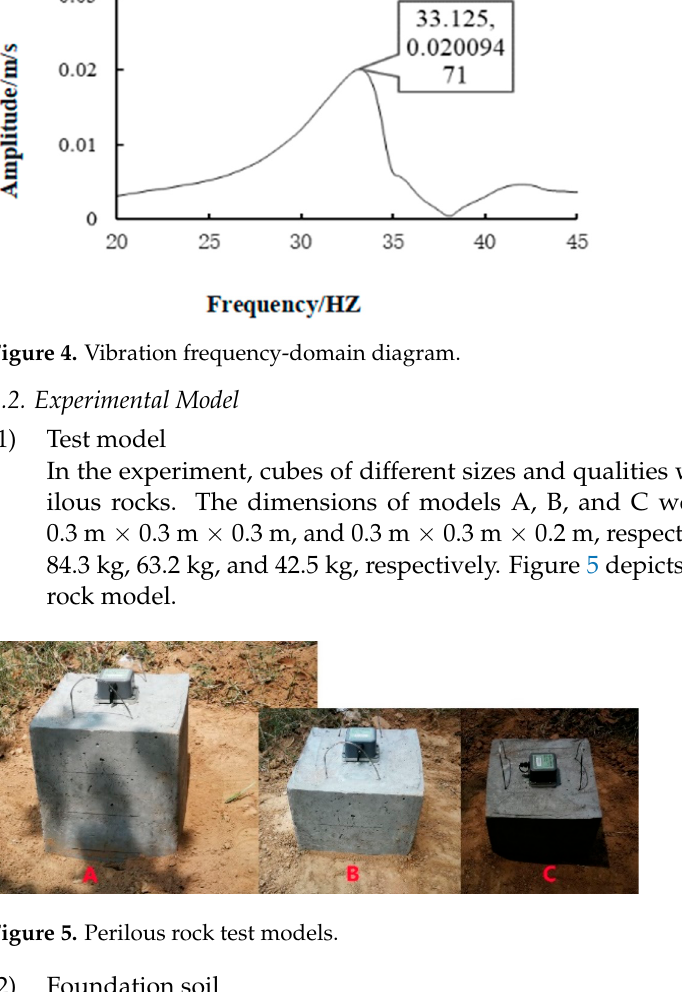
Table 2. Foundation soil